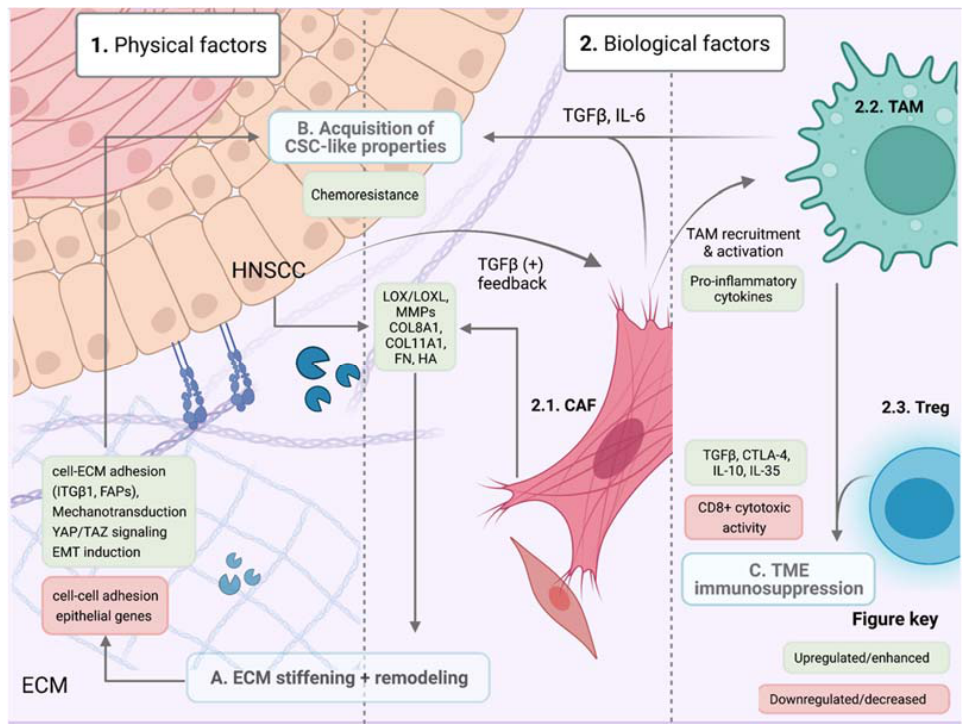
Figure 4. TME involvement in chemoresistance development. Tumor cell ‐ extrinsic influence on therapy response can be divided into physical (1) and biological (2) factors. HNSCC cells can recruit surrounding fibroblasts (middle section) through TGF β signaling, which induces an activation of the CAF phenotype (2.1). CAFs then further produce TGF β establishing a positive feedback loop between cancer and stromal cells. TGF β pathway activation promotes the deposition of matrix proteins (COL8A1, COL11A1, FN, HA) and remodeling enzymes (LOX/LOXL, MMPs), which help to reshape and shift the ECM composition. As a result, the matrix becomes stiffer ( A ), promoting cy ‐ toskeletal reorganization within HNSCC cells and thus cell–ECM interactions through increased FAP and integrin expression. Increased cell–ECM adhesion favors the activation of integrin ‐ depend ‐ ent signaling and mechanosensitive pathways (such as YAP/TAZ), which downregulate cell–cell interactions, enhancing motility and the acquisition of an EMT ‐ resistant phenotype ( B ). CAFs can also secrete inflammatory cytokines such as IL ‐ 6, which can both induce CSC ‐ like properties in HNSCCs (B) and recruit other TME populations, such as immune cells. TAMs (2.2) become active in response to proinflammatory cytokines to further secrete TGF β , supporting the activation of this pathway. Together with infiltrated T regulatory lymphocytes (2.3), they help to maintain an immu ‐ nosuppressed tumoral microenvironment which is likely to evade immunotherapy ( C ). Created with BioRender.com.